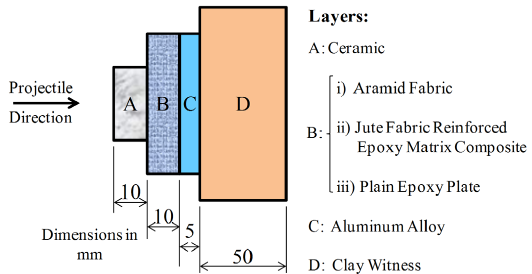
Figure 1. Schematic diagram of the multilayered armor.